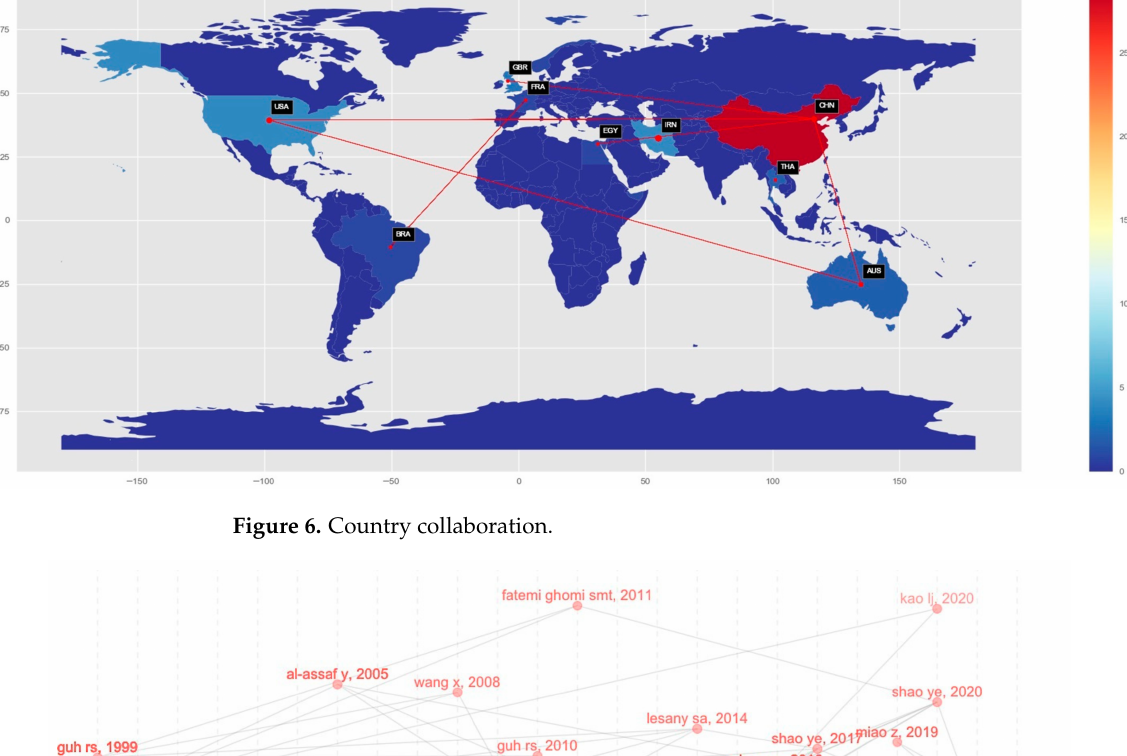
Figure 6. Country collaboration.